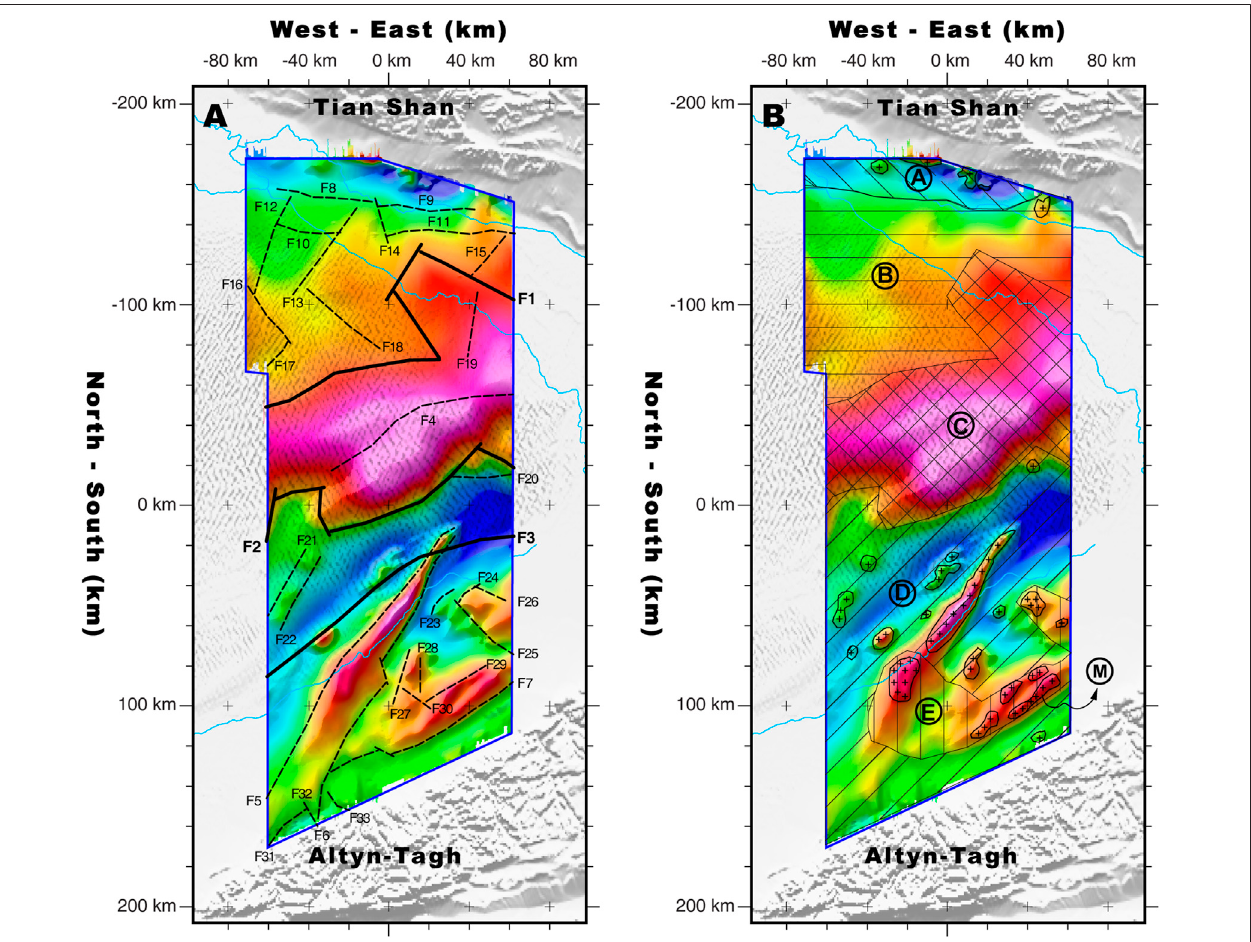
FIGURE 12 | Integrated interpretation map for faults and lithologic property of the crystalline basement. (A) Magnetic anomalies map with superimposed locations ofbasementfaults,theprimaryfaultsnumberedF1,F2,andF3arehighlightedinbold. (B) Thedomainsandtheirmarksoflithologicpropertyofthecrystallinebasement. Ⓐ :KongqueheSlope Domain (KSD); Ⓑ : Northeastern Mangal Domain (NMD); Ⓒ : Central Tadong Domain (CTD); Ⓓ : Southeastern Domain (SD); Ⓔ :RuoqiangDomain (RD); Ⓜ : magmatic rocks. See detailed interpretation in the text.